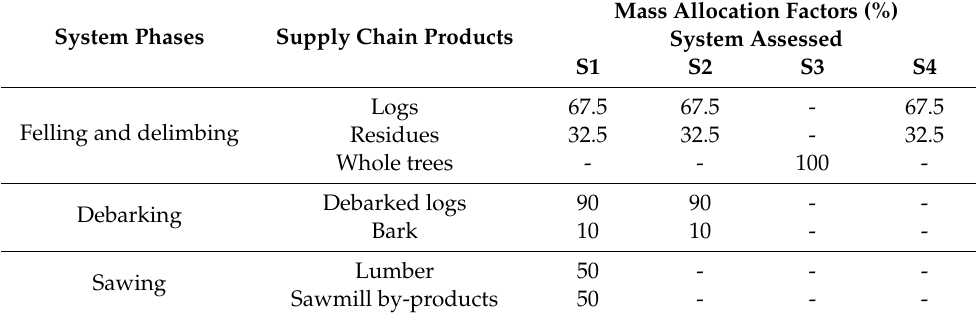
Table2. Massallocationfactorsusedinthefourwoodpelletsupplychainsassessed(S1: pelletsproduced from sawmill sawdust; S2: pellets produced from roundwood logs; S3: pellets produced from whole trees; S4: pellets produced from logging